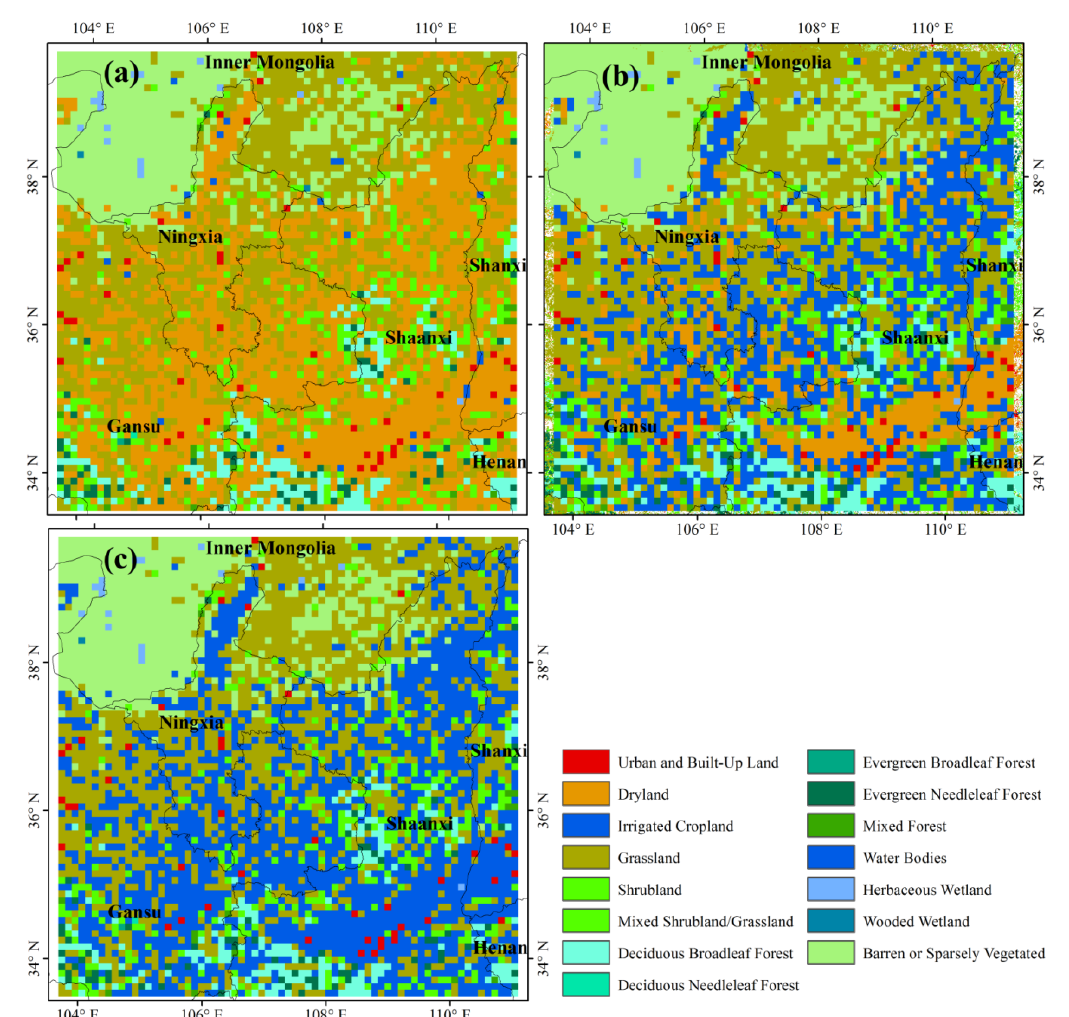
Figure 3. Three land cover scenarios of our study area, with ~10 km spatial resolution: ( a ) the control scenario (CON); ( b ) the irrigation scenario (IRR); and ( c ) the irrigated cropland expansion scenario